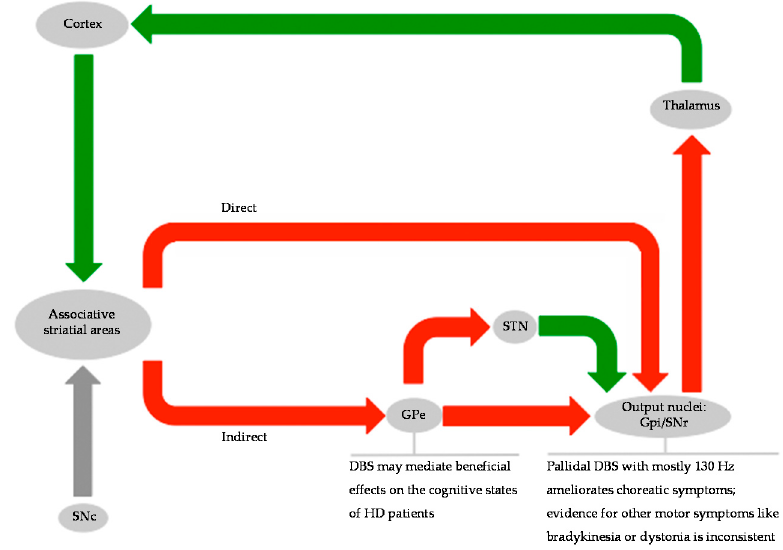
Figure 2. Basal ganglia network and targets for DBS in HD. Red arrows indicate inhibitory, green arrows indicate excitatory connections.